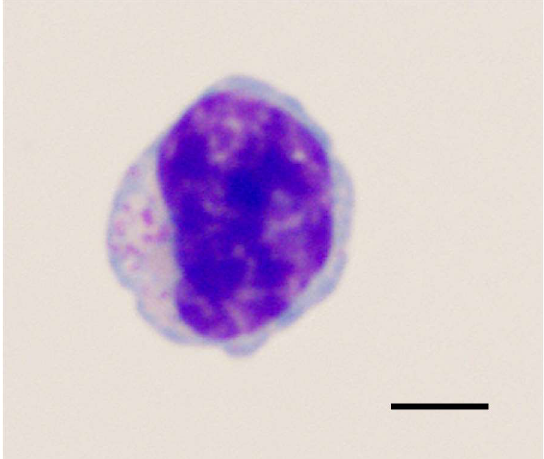
Figure 3. Cytological morphology of a large granular lymphocyte (LGL). Recent studies have determined that elevations in LGL phenotypes during both FIV and HIV infection may represent polyclonal T-cells with viral suppressive properties. Wright-Giemsa stain, bar = 5 μm.